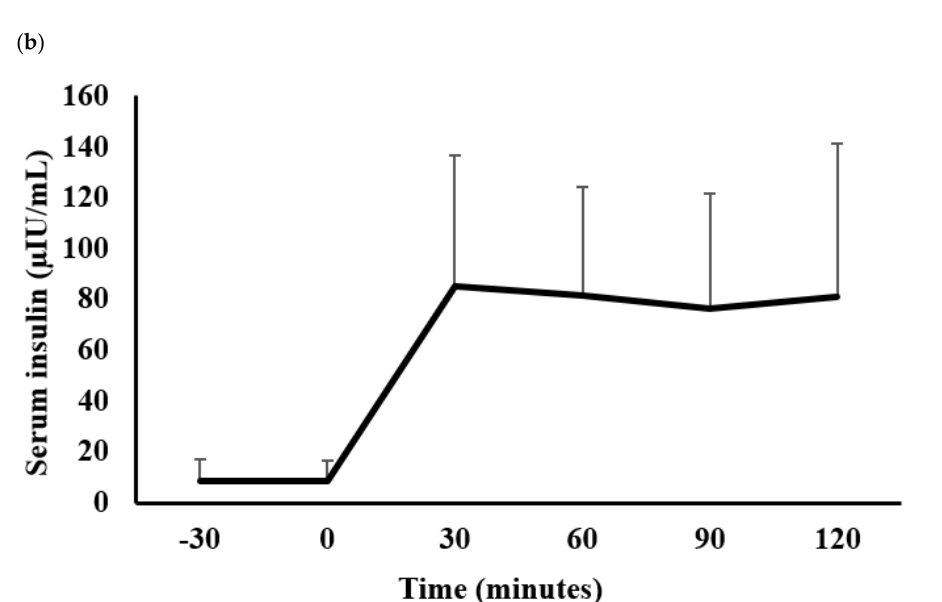
Figure 1. Glucose and insulin metabolism in the study volunteers. Plasma glucose ( a ) and serum insulin ( b ) responses to a 75 g oral glucose load. Data are mean ± SD.